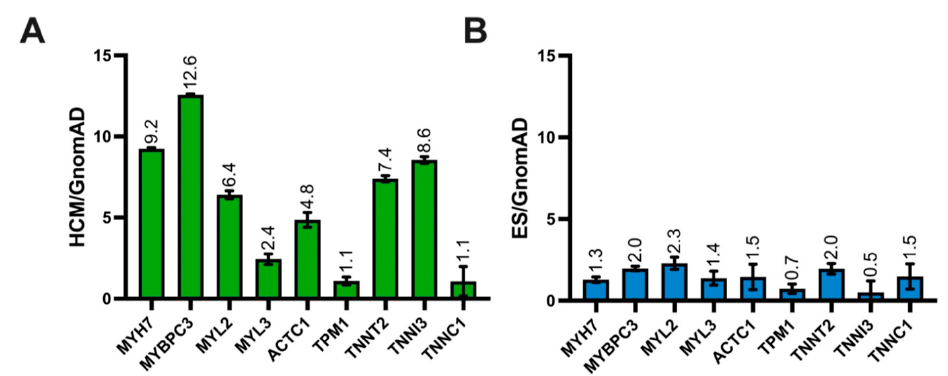
Figure 3. ( A ), Bar graph demonstrating the gene-level signal-to-noise ratios for each HCM-associated gene for the HCM case cohort compared with the gnomAD cohort. ( B ), Bar graph demonstrating the signal-to-noise ratios for each HCM-associated gene for the ES cohort compared with the gnomAD cohort. Error bars denote 95% CI.